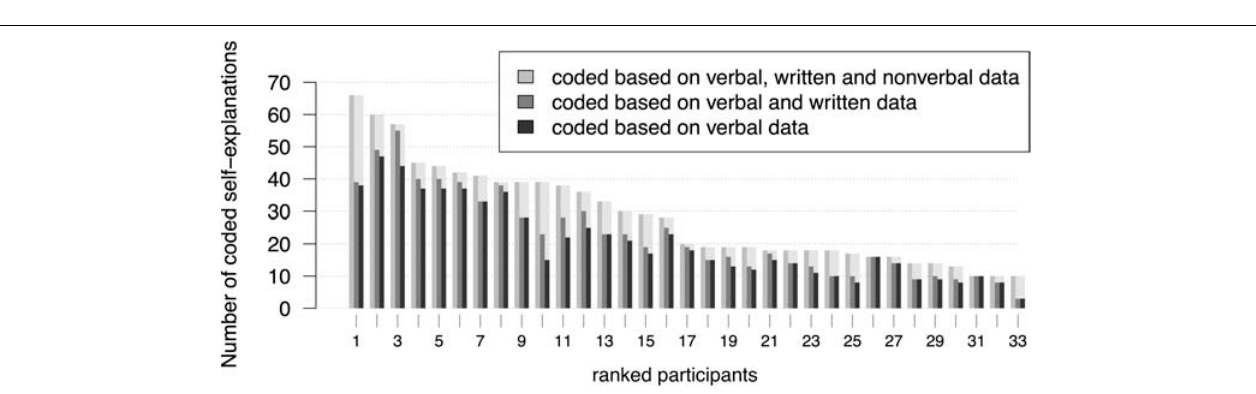
FIGURE 3 | Numbers and percentages of self-explanations coded during the three coding procedures.